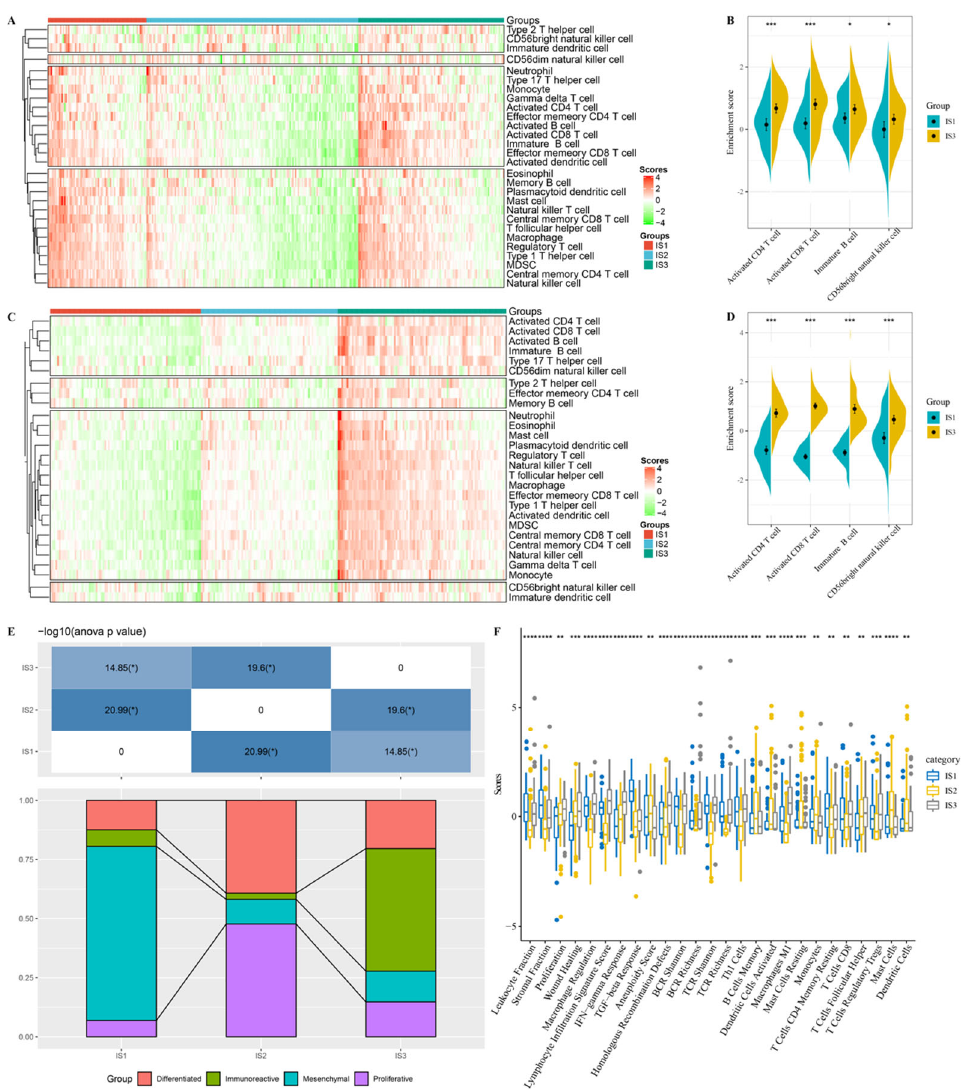
Figure 5. Characteristics of TIICs of the immune subtypes. ( A , C ). Differential enrichment scores of 28 TIICs among three subtype in the TCGA ( A ) and GSE32062 cohort ( C ). ( B , D ). Several immune cell enrichment scores in the TCGA cohort ( B ) and GSE32062 cohort ( D ) with significant differences between IS1 and IS3 subtypes. ( E ). Overlap of three immune subtypes with TCGA molecular typing of OC. ( F ). Enrichment scores of 26 immune ‐ related characteristics with significant differences among three immune subtypes. * p < 0.05; ** p < 0.01; *** p < 0.001; **** p < 0.0001.